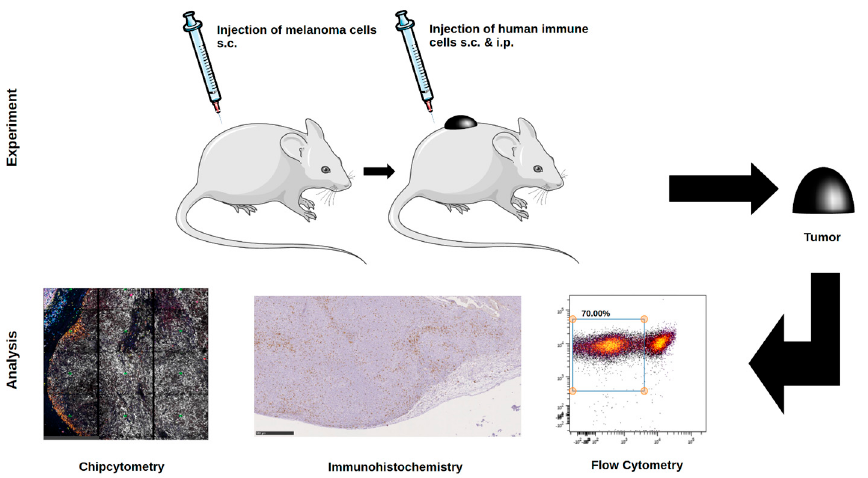
Figure 1. Schematic of the melanoma model in the humanized mice. After subcutaneous injection of human Ma-Mel-19 melanoma cells in NOD Scid tgHLA-A2.1 mice, human immune cells were injected at the tumor site s.c. and i.p. After three more weeks, ex vivo analysis of tumor was performed using Chipcytometry, immunohistochemistry, and flow cytometry.